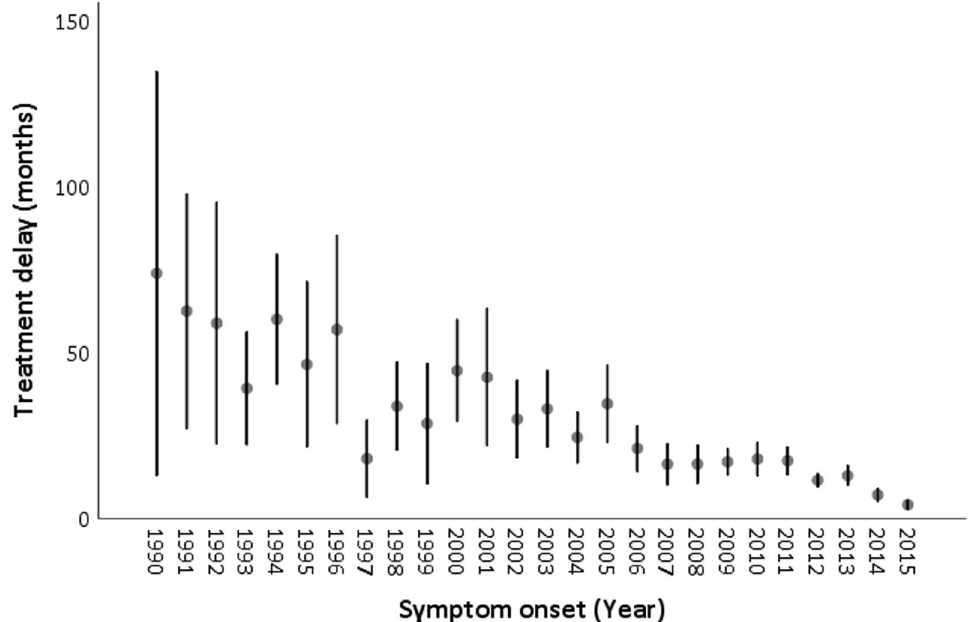
Fig. 2 Rheumatoid arthritis treatment delay (months) according to the year of symptoms onset in Brazil. Note : The dots and bars represent the point estimates and 95% confidence intervals for the means, respectively